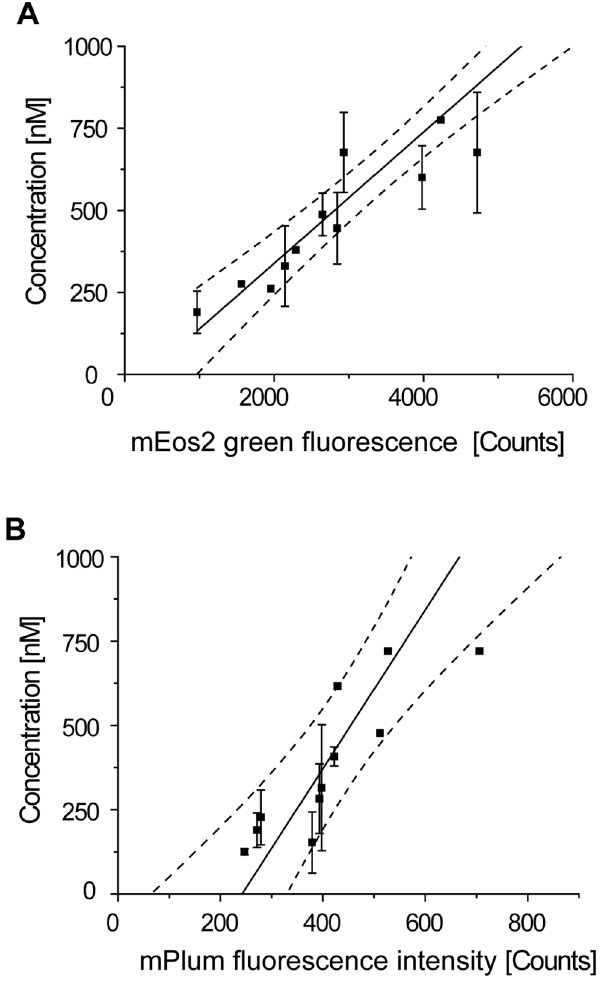
Figure 3. Calibration curves obtained with FCS. The molar concentration of ( A ) mEos2 and ( B ) mPlum is shown as a function of the integrated cytosolic fluorescence intensity. Counts are given in arbitrary units and refer to the integrated fluorescence intensity of the wide-field image of the cell. Mean and standard deviation from three measurements within one cell are shown. A linear fit (solid line) with a 95% confidence interval (dashed lines) is shown. The extrapolated linear fit of the fluorophore concentration as a function of the integrated fluorescence intensity was used for the determination of protein expression